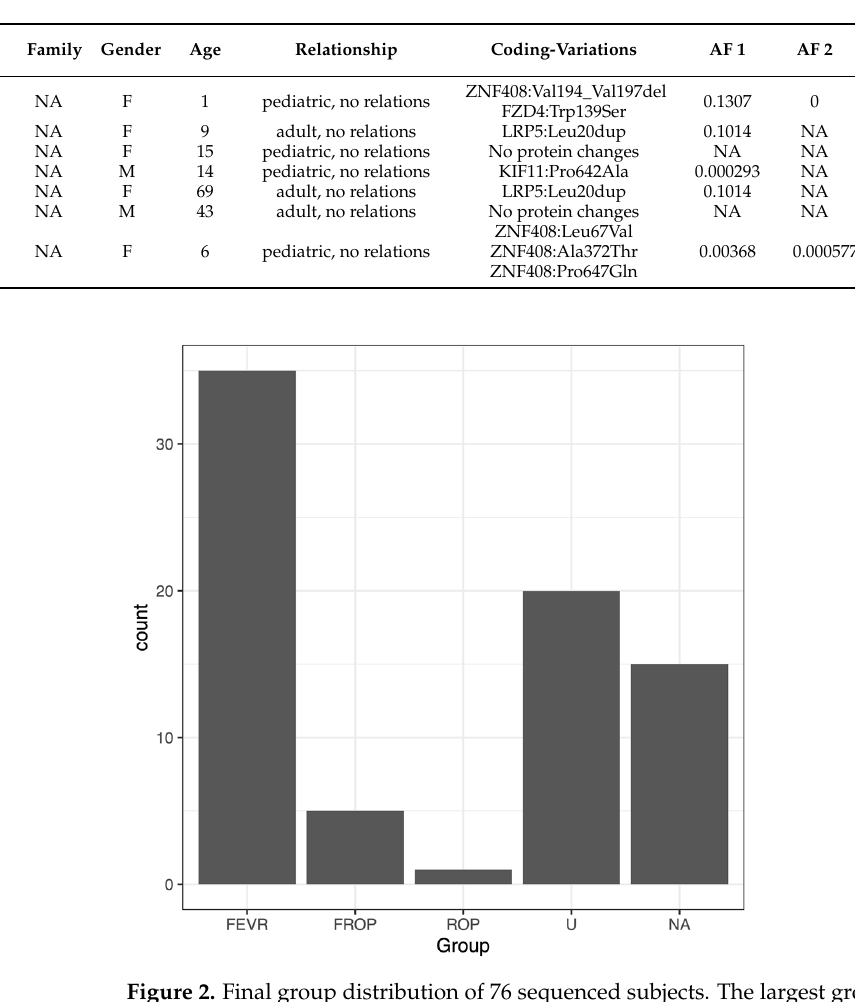
Figure 2. Final group distribution of 76 sequenced subjects. The largest grouping contained patients confirmed in the ARC clinic with FEVR (35). ARC confirmed FEVR-Unaffected subjects (U) numbered 20. Five pediatric subjects were categorized as ROP with potential FEVR complication (FROP), while one pediatric subject was ROP. Fifteen subjects, mostly relatives of FEVR patients, were not available to ARC for retinal diagnosis (NA).